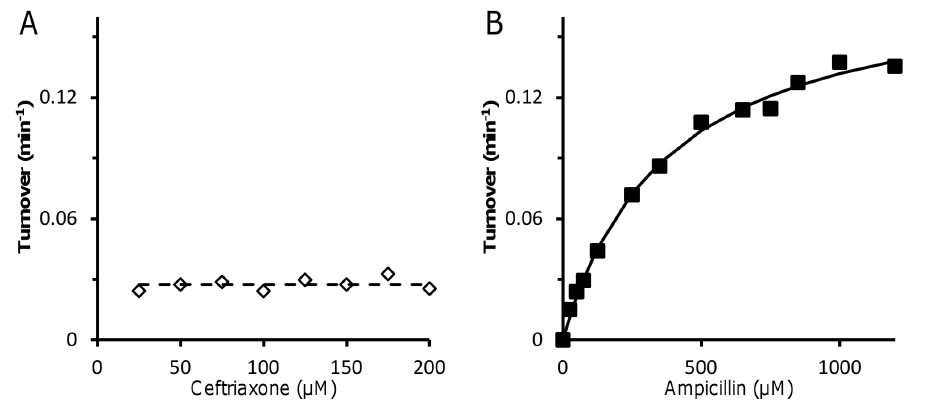
Figure 5. Determination of turnover numbers for full catalytic cycles leading to hydrolysis of b -lactams by Ldt fm . Turnover numbers were determined for hydrolysis of ceftriaxone (A) and ampicillin (B) by Ldt fm (5 m M).